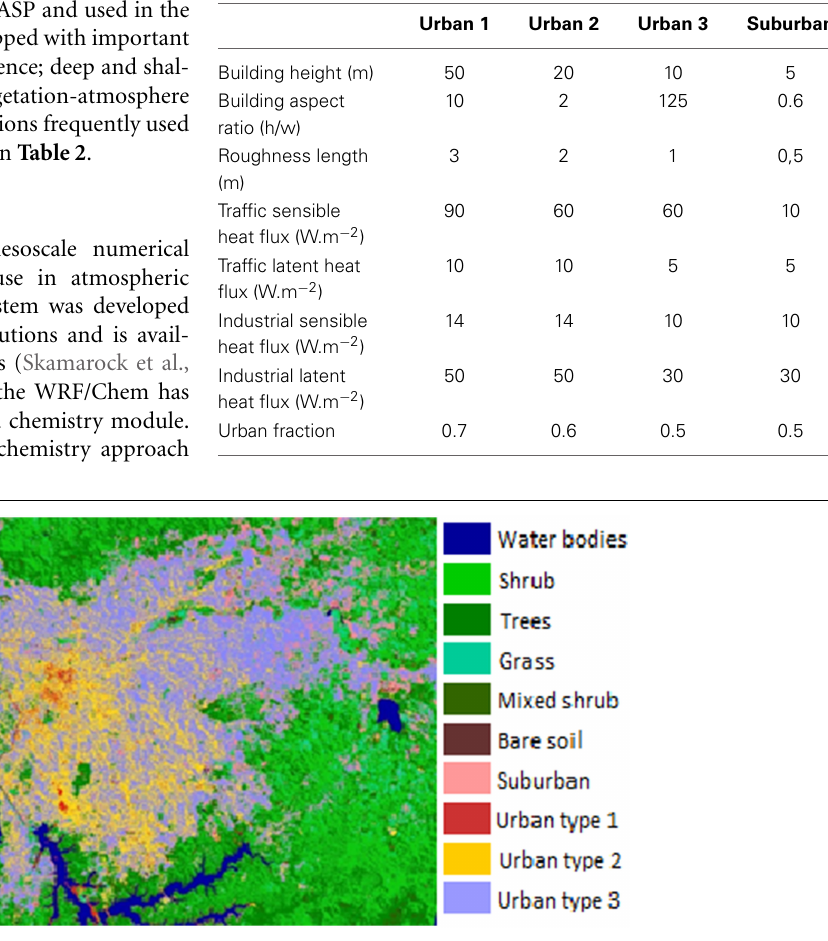
FIGURE 2 | Land Use/Land Class image used in the BRAMS-SPM model for the Metropolitan Area of São Paulo. Adapted from Gouvêa